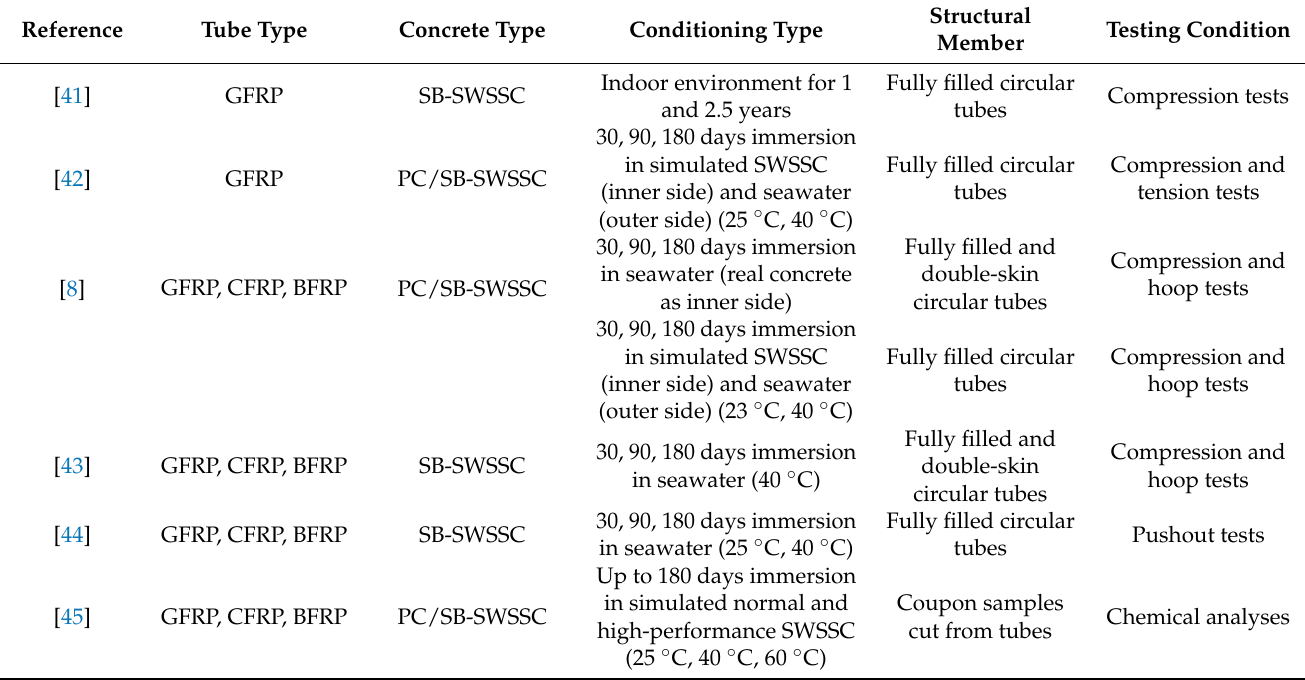
Table 2. Research studies on durability of SWSSC filled FRP tubes adopted from [22], with permission from Elsevier,